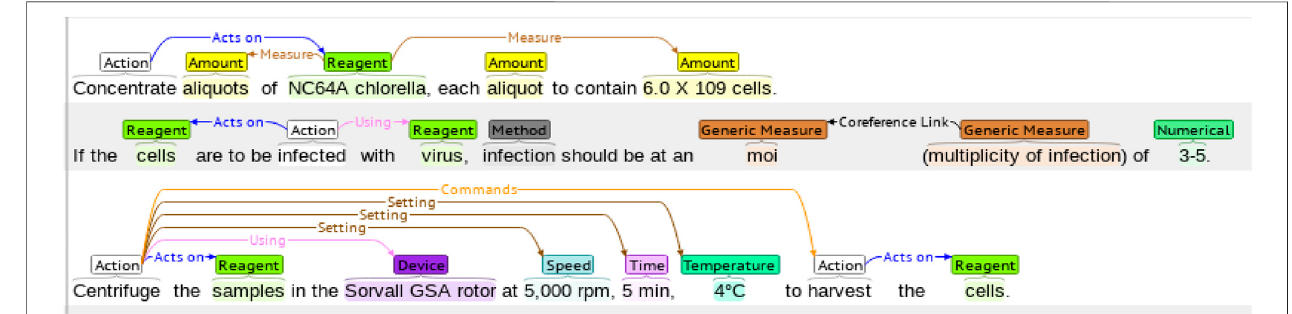
FIGURE3| AnexampleofawetlabprotocoloftheWNUTdatasetwithentityannotations.Theannotationsarecolor-coded,representingthedifferententitiesinthe dataset.